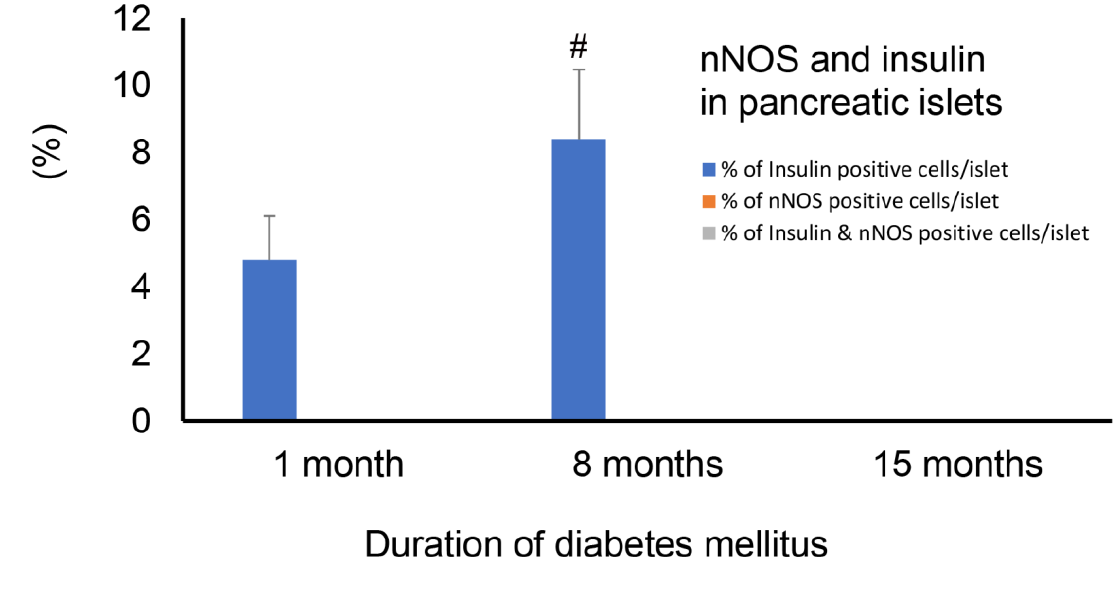
Figure 5. ( a ) shows insulin-(green) and nNOS-(red)-immuno-positive cells in the islet of Langerhans of rats 1, 8 and 15 months after induction of diabetes. No co-localization between nNOS and insulin was observed after the induction of diabetes. nNOS-immunoreactive ganglion cell (arrow) and nerve fibres (arrow head) were observed in the exocrine pancreas. Scale bar = 10 μm. ( b ) shows morphometric analysis of the insulin-positive cells in the islet cells of the endocrine pancreas. Note the slight but significant (# p < 0.01) increase in the number of insulin-containing cells after 8 months of diabetes compared to 1 month. (n = 6).